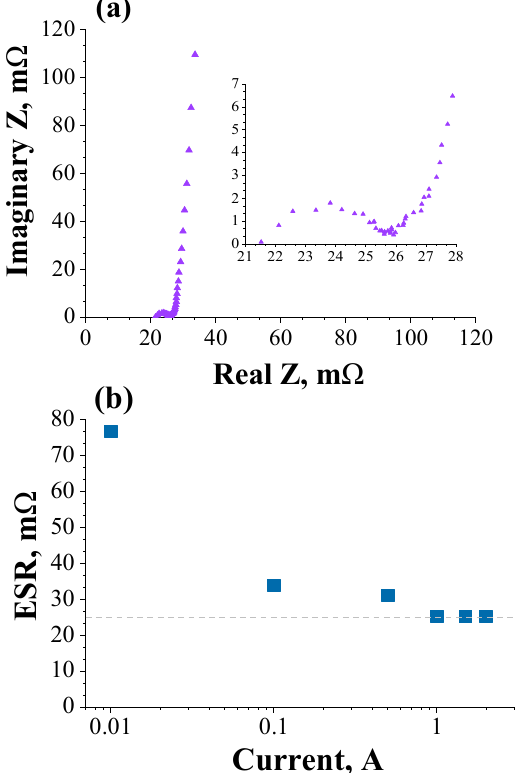
Figure 5. ( a ) Nyquist plot obtained for the commercial supercapacitor of 200 F. ( b ) Equivalent series resistance obtained from the GCD method as a function of the applied current.